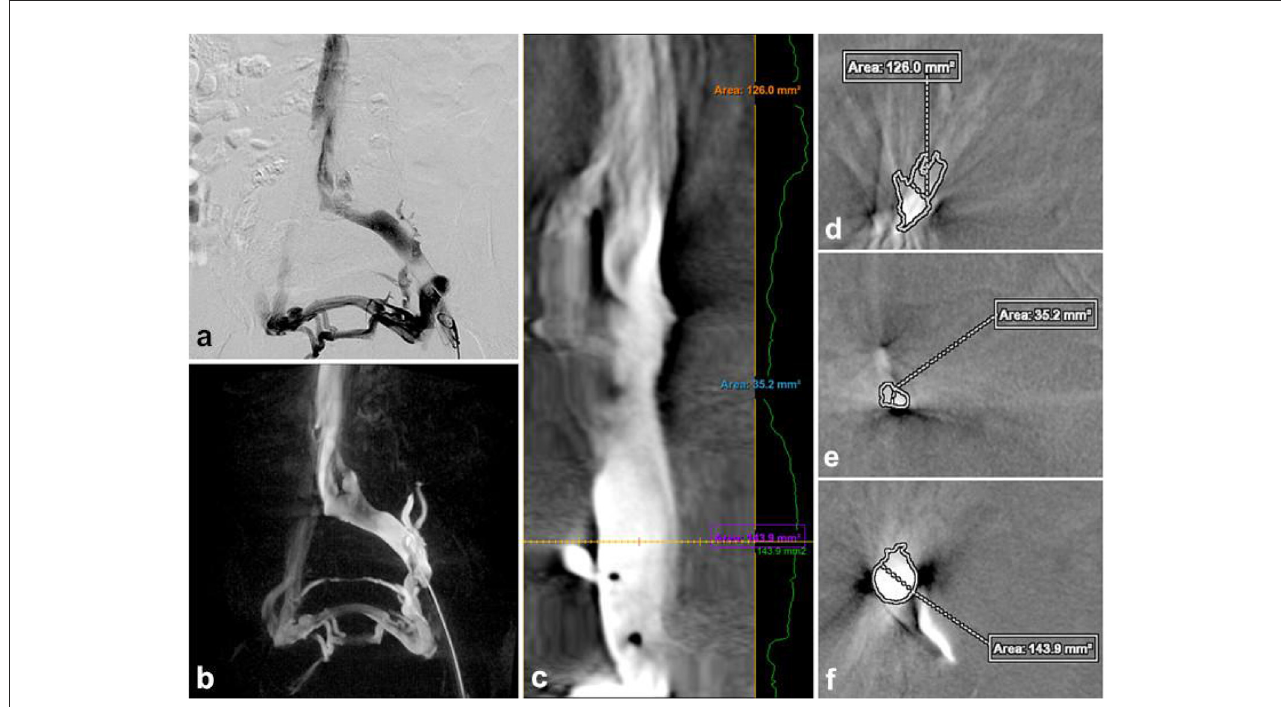
FIGURE1 Traditional DSA image (a) , 3D-RV image (b) , the vascular was straightened (c) to measure the normal area of the proximal (d) and distal of the stenosis (f) , the cross-sectional area at the narrowest point (e) . Stenosis rate = [1 – (2Se/Sd + Sf)] × 100% = [1–2 × 35.2/126 + 143.9] 100% =